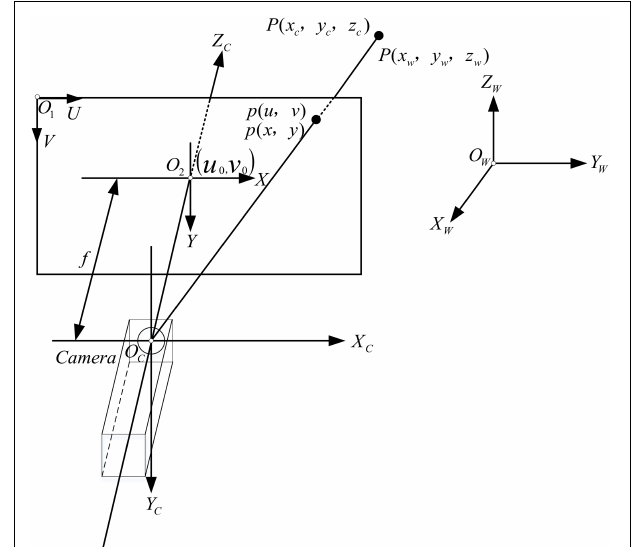
FIGURE 3 | Schematic diagram of pinhole imaging.